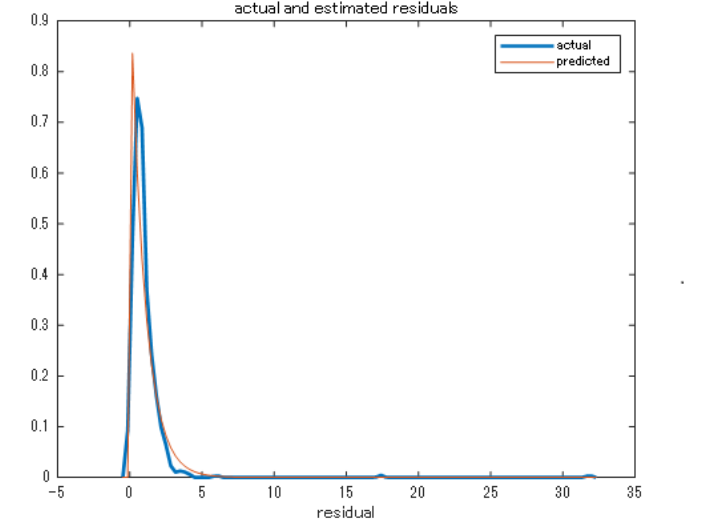
Figure 1. Actual and estimated distribution of